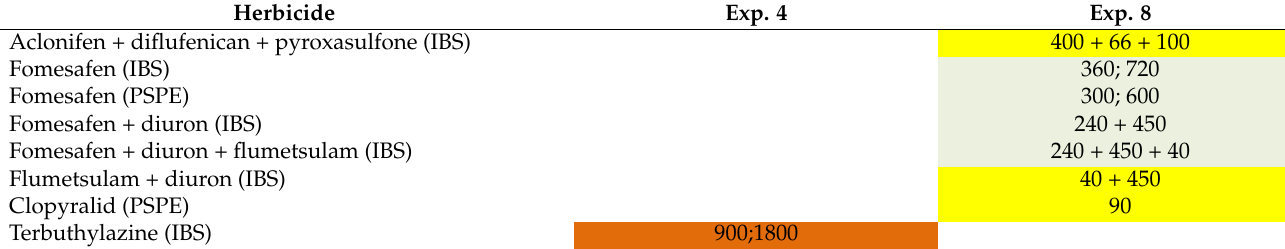
Table 15. Tedera tolerance to pre-emergent herbicides to control pre- and post-emergent broadleaf weeds. Herbicides/rates (a.i. g/ha) in green or yellow were not significantly different to an un- sprayed control, with those in green causing less than 10% biomass reduction and those in yellow causing more than 10% biomass reduction. Those in red had significantly less biomass than the un-sprayed